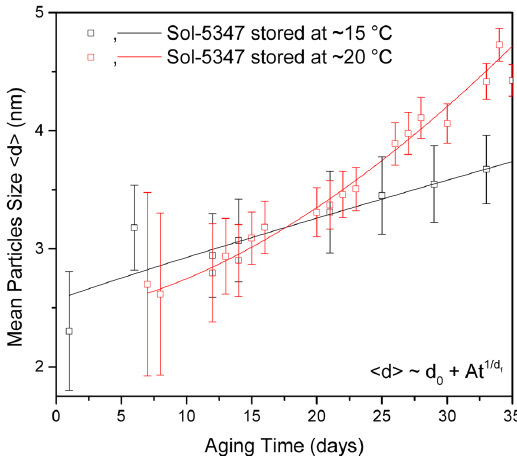
Figure 6. Evolution of the mean particles size as samples of a PZT 53/47 precursor aged under two different ambient conditions. Fittings are based on a DLCA aggregation mechanism.